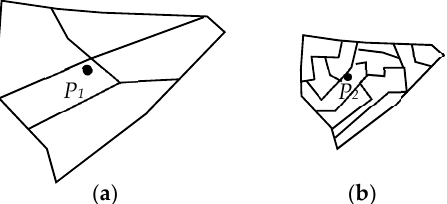
Figure 10. Measurement of points’ weights. ( a ) Network Voronoi polygon of P 1 and ( b ) network Voronoi polygon of P 2 .